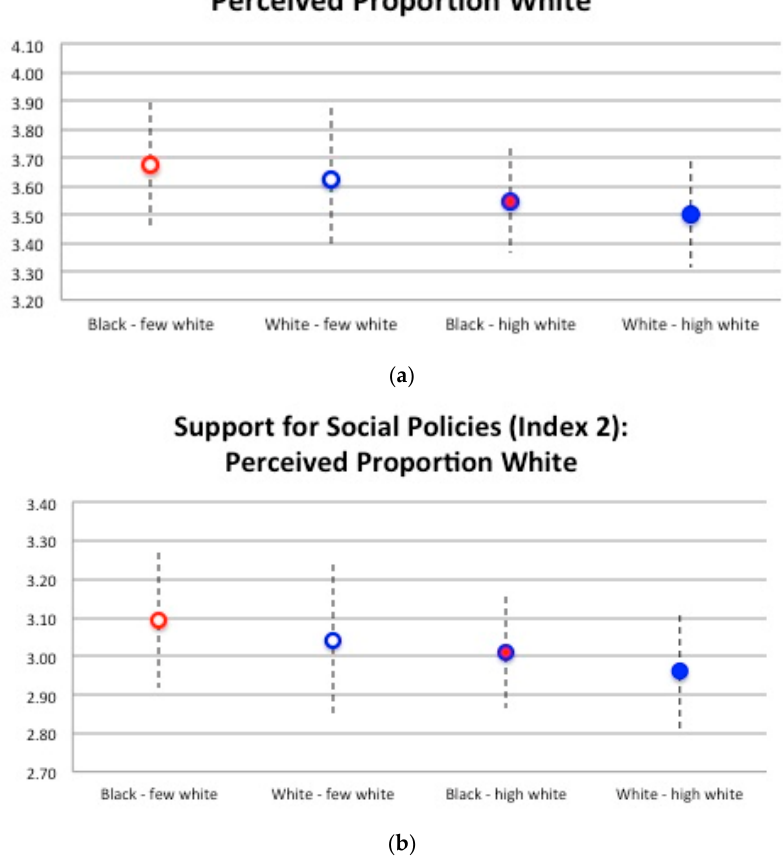
Figure 9. Predicted probabilities of support for redistribution ( a ) and social policies ( b ) by perceived proportion of whites for white and black respondents.